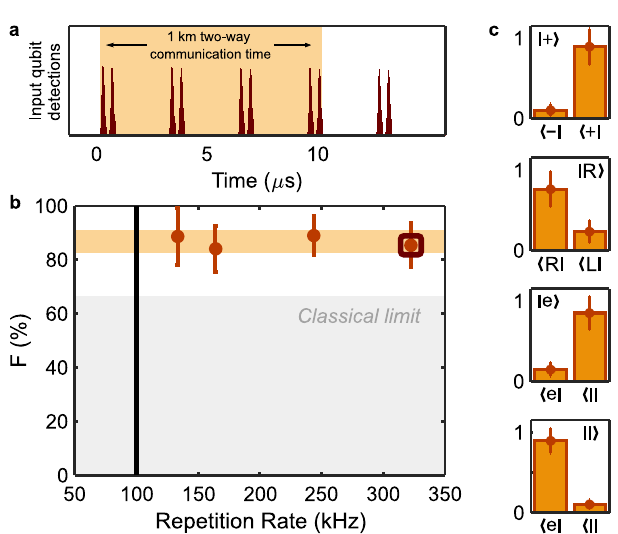
Fig. 3 | Multiplexing capabilities and long distance teleportation. a Example of the qubit sequence that we send from Bob. Each pair of peaks represents a qubit teleportation attempt. In this example, four teleported modes are stored at the sametime(orangeshadedarea). b Fidelityversusteleportationrepetitionrate.The highlighted point corresponds to the qubit sequence of Fig. 3a. The light grey shaded area represents the classical limit and black line shows the maximum repetition rate thatasingle modememorycouldhave when used forteleportation overa1kmdistance.Thesolidorangebandrepresentsa±1 σ variationwithrespect to the mean value between all the measured fi delities. c Long distance quantum teleportation. We used 1 km of optical fi bre between Alice and Bob and an AFC in the QM of 17.5 μ s . The histograms show the normalised coincidences for different input qubits using a parallel and orthogonal setting of the analyser. The error bars correspond to±1 σ